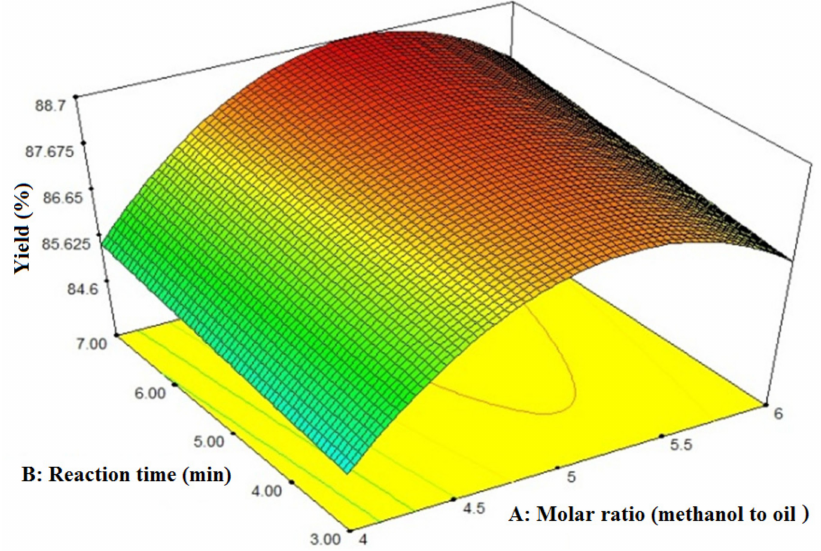
Figure 3. E ff ect of reaction time and molar ratio on yield (methyl ester content) at a pulse of 0.4